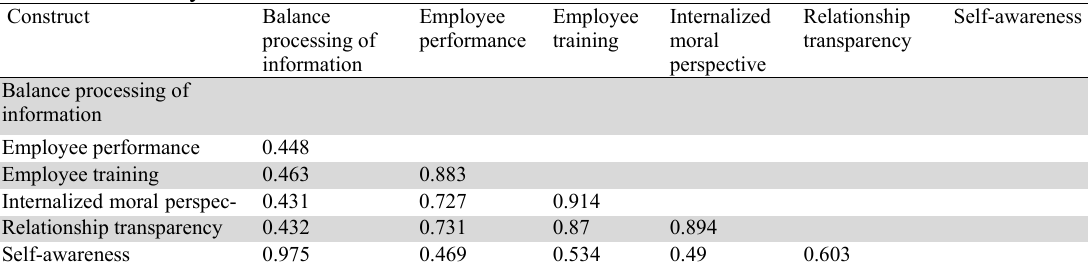
Constructs validity results